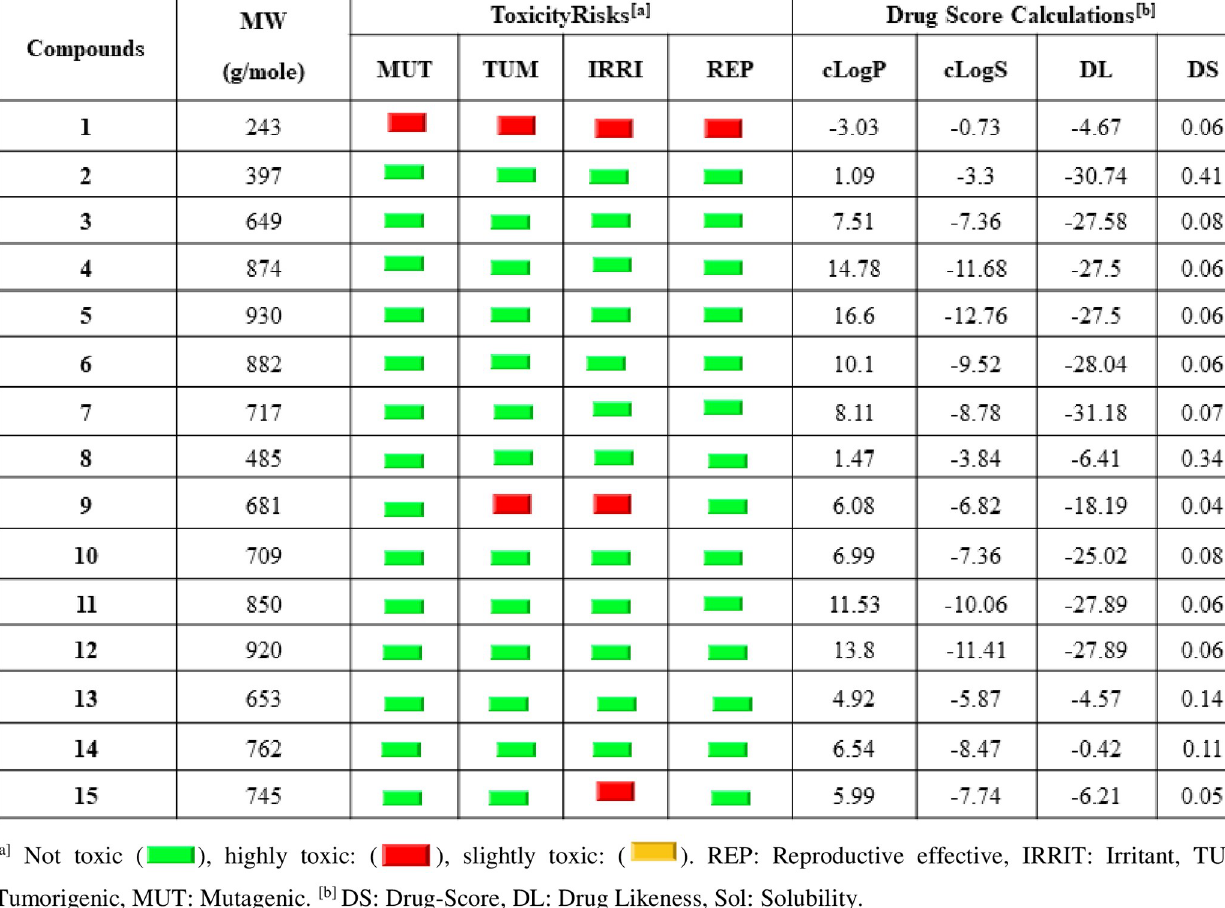
PLOS ONE | https://doi.org/10.1371/journal.pone.0273256 November28,